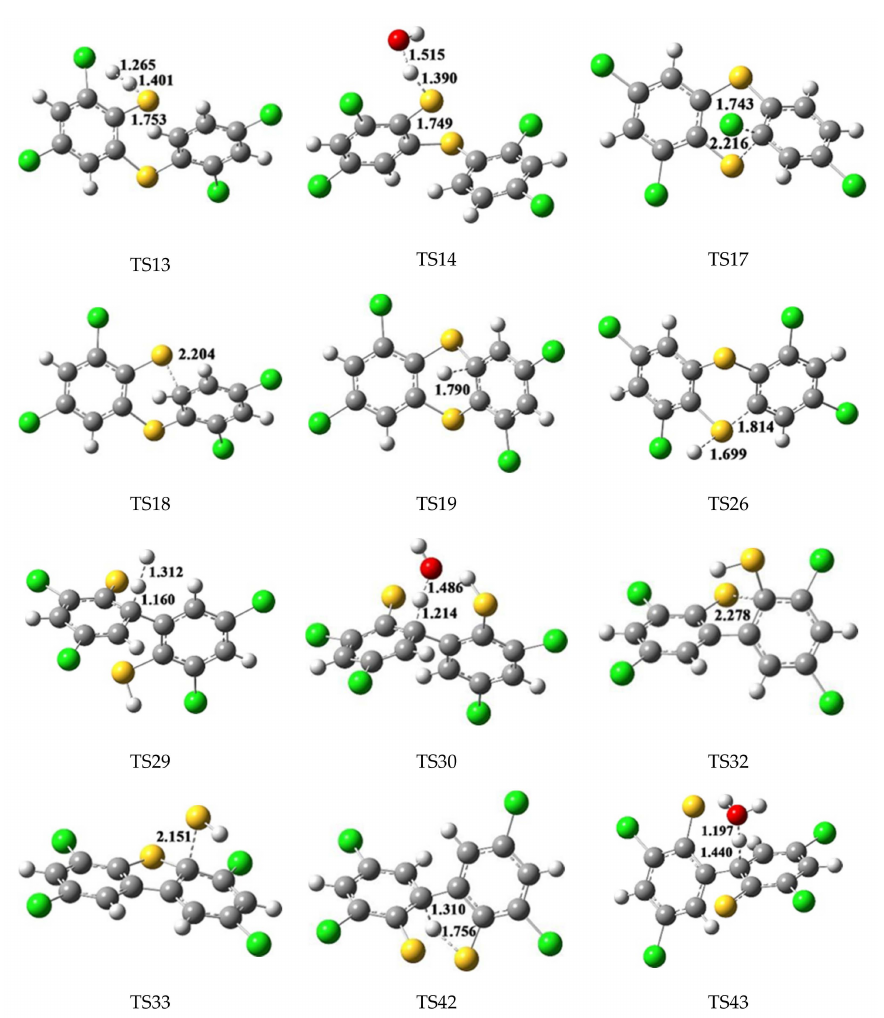
Figure 5. MPWB1K / 6-31 + G(d,p) optimized transition state geometries in the formation of PCTA / DTs. The bond distances are given in Å. Green, gray, yellow, red and white balls denote Cl, C, S, O and H atoms,